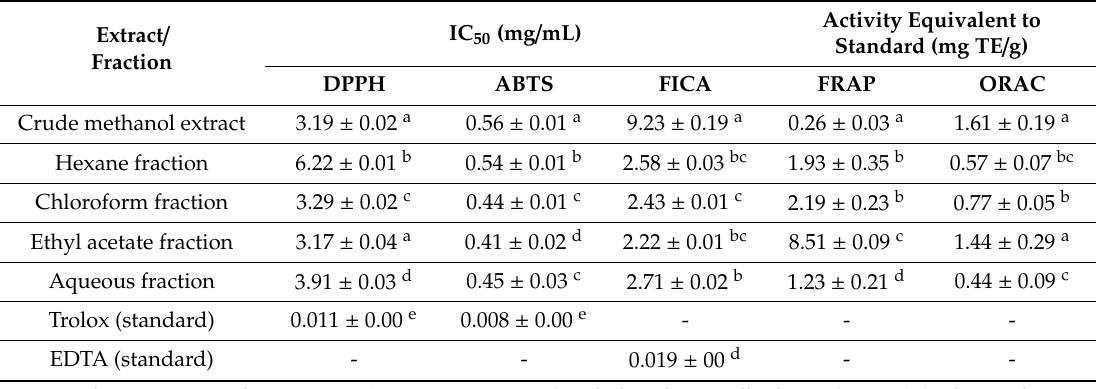
Table 2. IC 50 values of methanol extract of G. edulis and fractions against antioxidant activity and activities equivalent to standards.